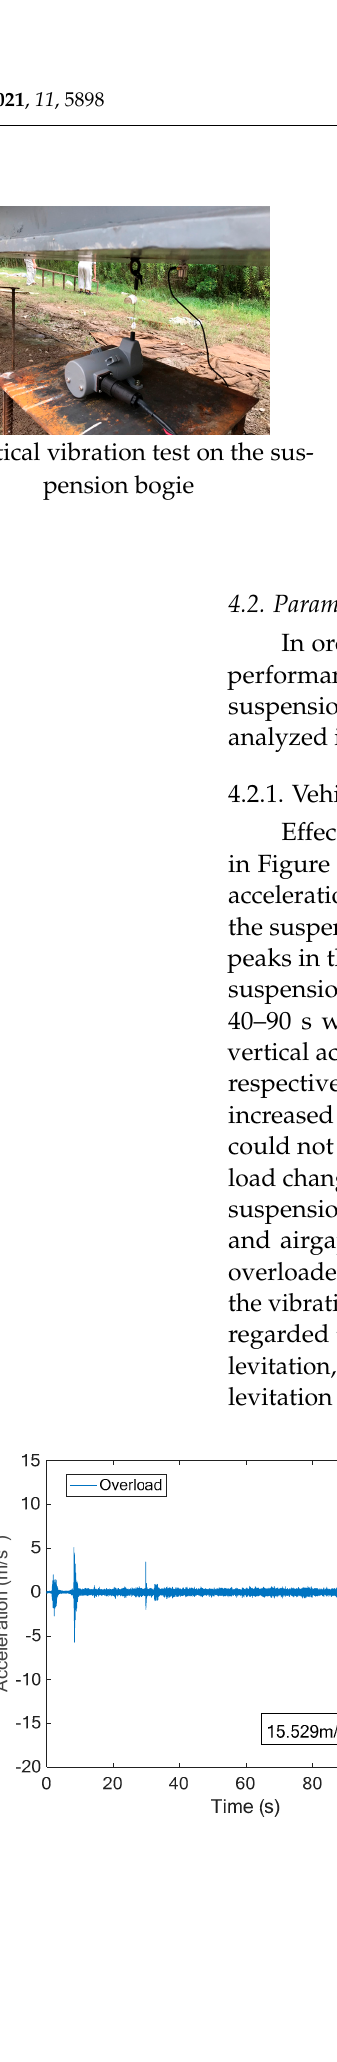
Figure 6. Arrangement of test points.